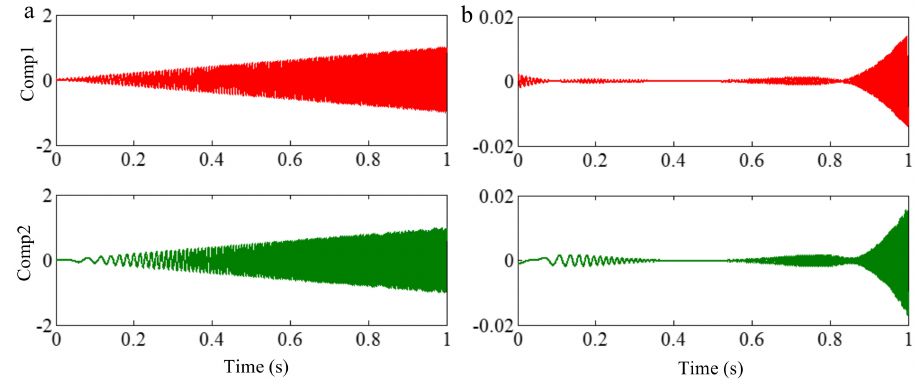
Figure 40. The STFT of the sample signal f sig 8 : ( a ) 2D figure and ( b ) 3D figure.